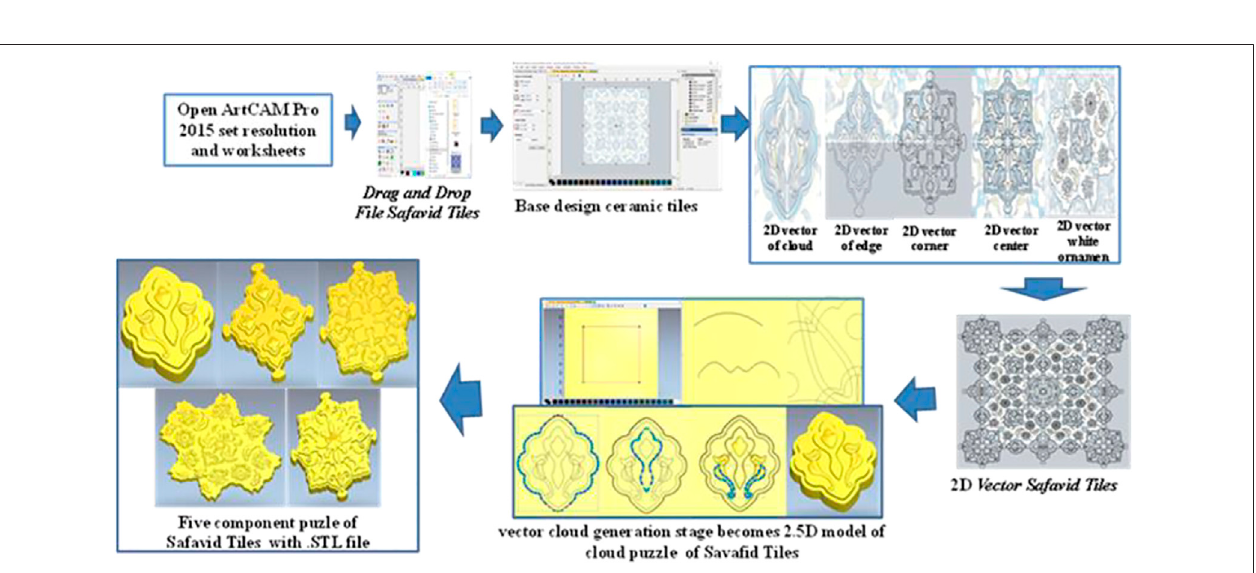
FIGURE 11 | Stages of vector generation from .jpg fi le to .stl fi le in ArtCAM Pro2015.